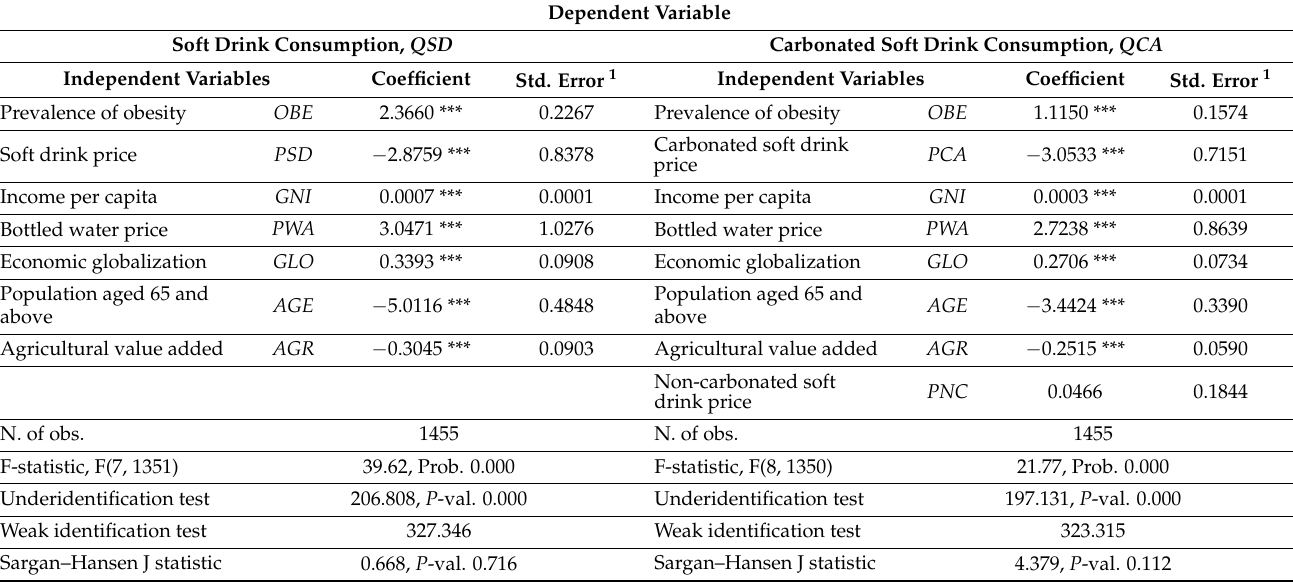
Table 2. Instrumental variable (IV) regression results: assessing the impact of the prevalence of obesity on the demand for soft